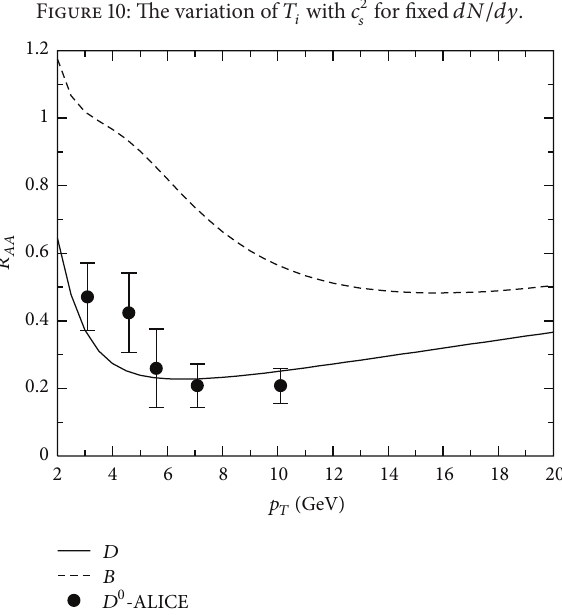
Figure 11: 𝑅 𝐴𝐴 as a function of 𝑝 𝑇 for 𝐷 and 𝐵 mesons at LHC. Experimental data taken from